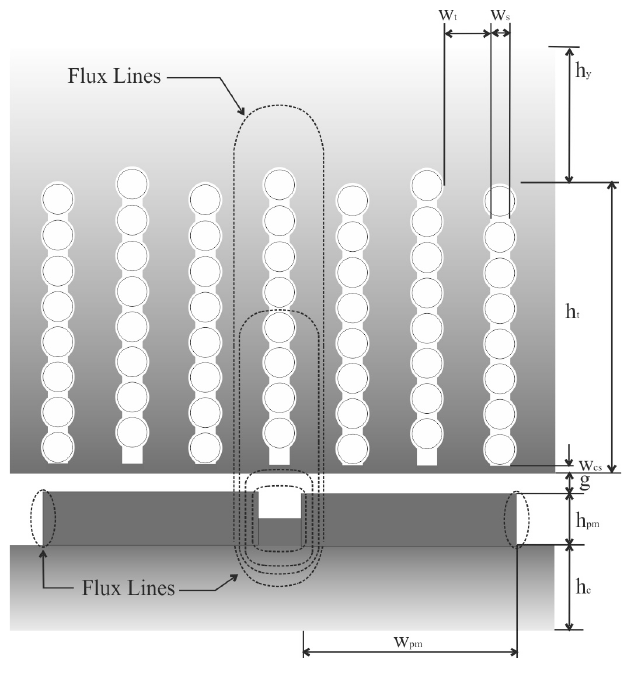
Figure 4. Magnetic equivalent